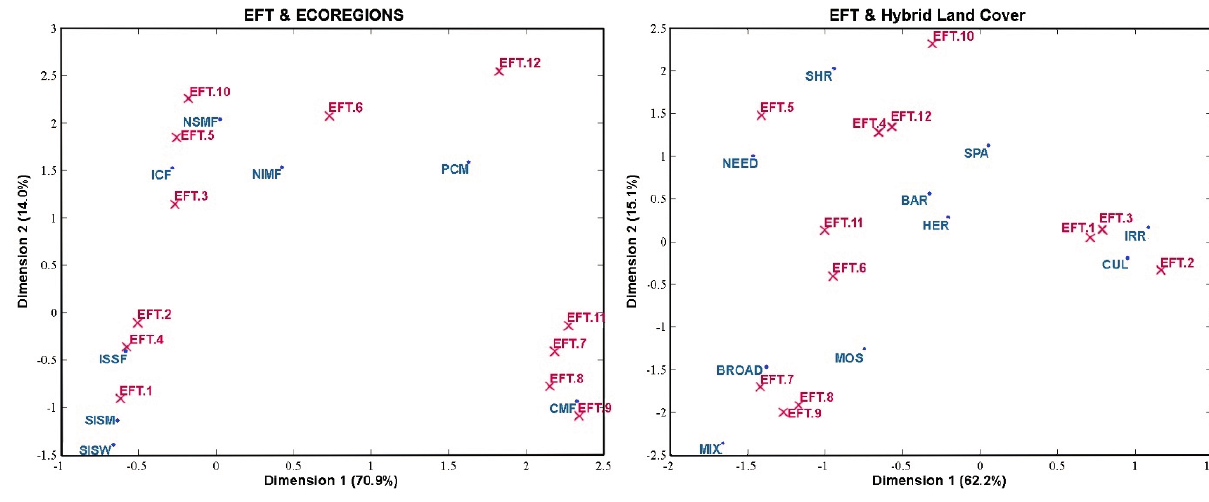
Figure 10. Correspondence analysis between Ecosystem Functional Types (EFTs) and ( Left ) ecoregions (SISW: Southeastern Iberian Shrub and Woodlands, SISM: Southwest Iberian Mediterranean Sclerophyllous and Mixed Forest, ISSF: Iberian Sclerophyllous and Semi-deciduous Forest, CMF: Cantabrian Mixed Forest, PCM: Pyrenees Conifer and Mixed Forests, NIMF: Northwest Iberian Montane Forest, ICF: Iberian Conifer Forest, NSMF: Norhteastern Spain and Southern France Mediterranean Forest) and ( Right ) hybrid land cover (CUL: Cultivated and Managed areas, IRR: Irrigated Areas, MOS: Mosaic